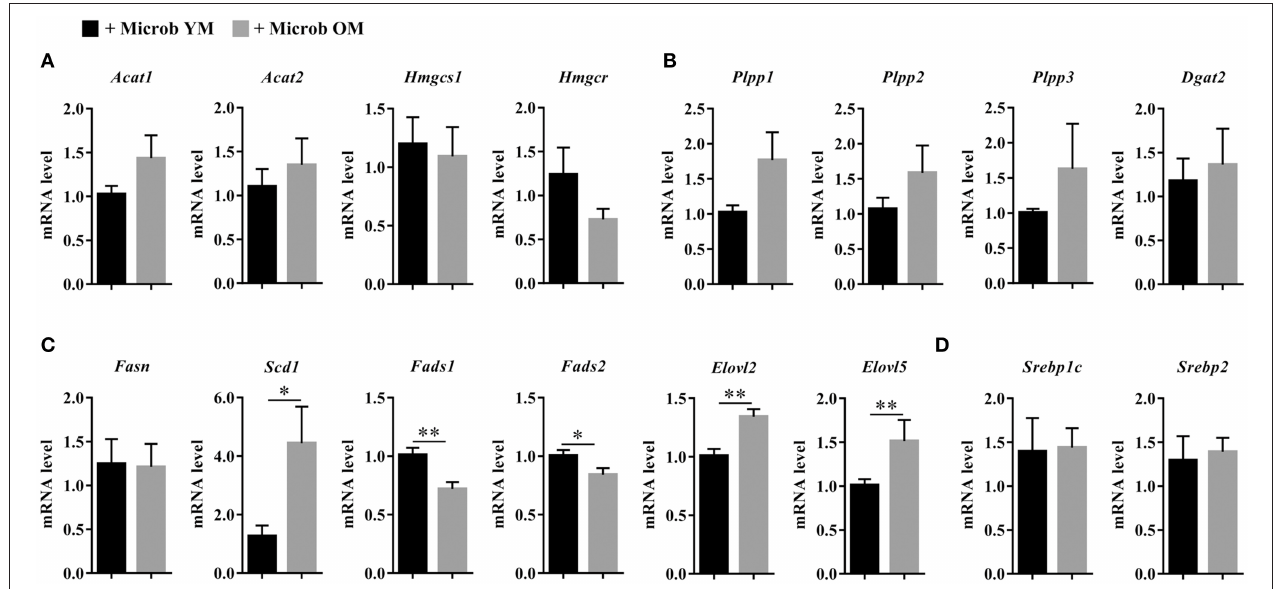
FIGURE 7 | Expression of hepatic genes involved in lipid biosynthesis. (A) Hepatic expression of genes encoding enzymes involved in the biosynthesis of cholesterol: acetyl-CoA acetyltransferase 1 and 2 ( Acat1 and Acat2 ), hydroxymethylglutaryl-CoA synthase ( Hmgcs1 ) and 3-hydroxy-3-methylglutaryl-CoA reductase ( Hmgcr ). (B) Hepatic expression of genes encoding enzymes involved in the biosynthesis of di- and triglycerides: phospholipid phosphatases 1, 2, and 3 ( Plpp1 , Plpp2 and Plpp3 ) and diacylglycerol O-acyltransferase 2 ( Dgat2 ). (C) Hepatic expression of genes encoding enzymes involved in the biosynthesis of fatty acids: fatty acid synthase ( Fasn ), acyl-CoA desaturase 1 ( Scd1 ), acyl-CoA (8-3)-desaturase ( Fads1 ), acyl-CoA 6-desaturase ( Fads2 ), and elongation of very long chain fatty acids proteins 2 and 5 ( Elovl2 and Elovl5 ). (D) Hepatic expression of genes encoding enzymes involved in the regulation of lipid synthesis: sterol regulatory element-binding proteins 1 (variant 3) and 2 ( Srebp1c and Srebp2 ). The levels of mRNA were normalized to Hprt mRNA level for calculation of the relative levels of transcripts. mRNA levels are illustrated as fold change. All data are presented as mean ± SEM. n = 7 for the group of mice inoculated with the microbiota of young mice and n = 8 for the group of mice inoculated with the microbiota of old mice. Comparisons were done between the two groups of mice ( + Microb YM and + Microb OM). * p < 0.05 and ** p <